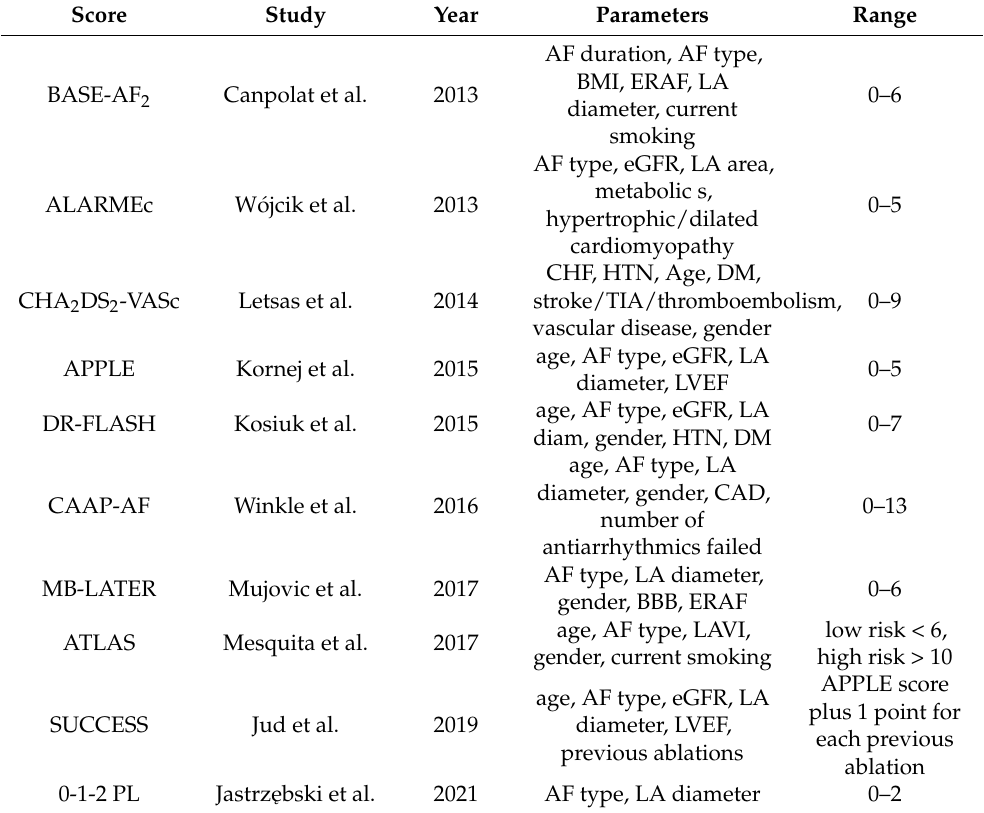
Table 1. Clinical scores used to predict AF recurrence after successful AF